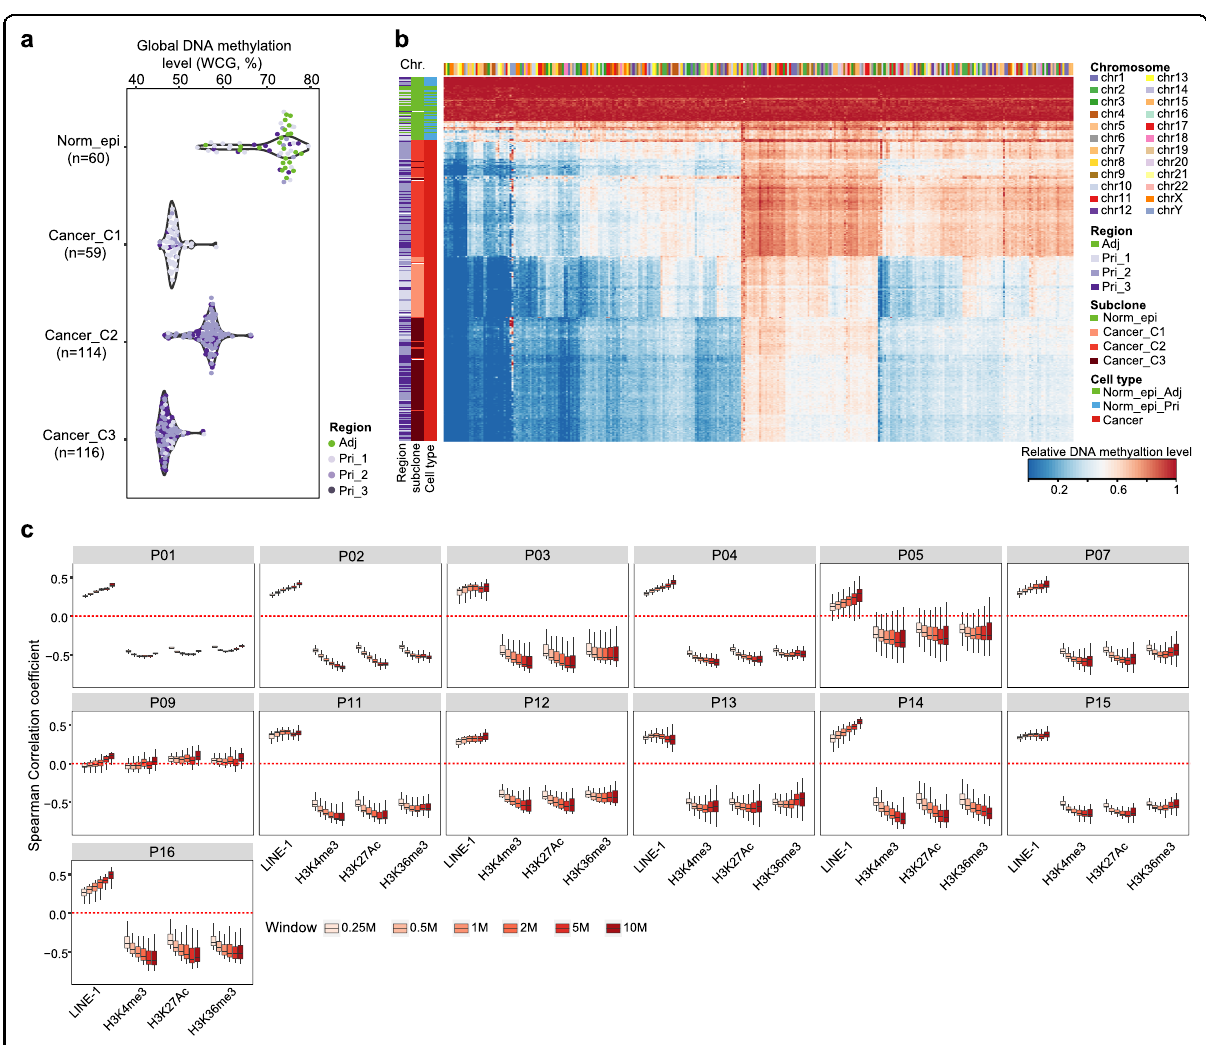
Fig. 4 Genome-wide DNA demethylation in cancer cells is strongly enriched in heterochromatin regions. a Global DNA methylation levels (1 kb tile) of single cells in each subclone of P11. b Genome-wide DNA demethylation heatmap (10 Mb window) of cancer cells compared to all Norm_epi cells in P11. c Spearman correlations between DNA demethylation levels and the densities of genomic landmarks under different resolutions in each